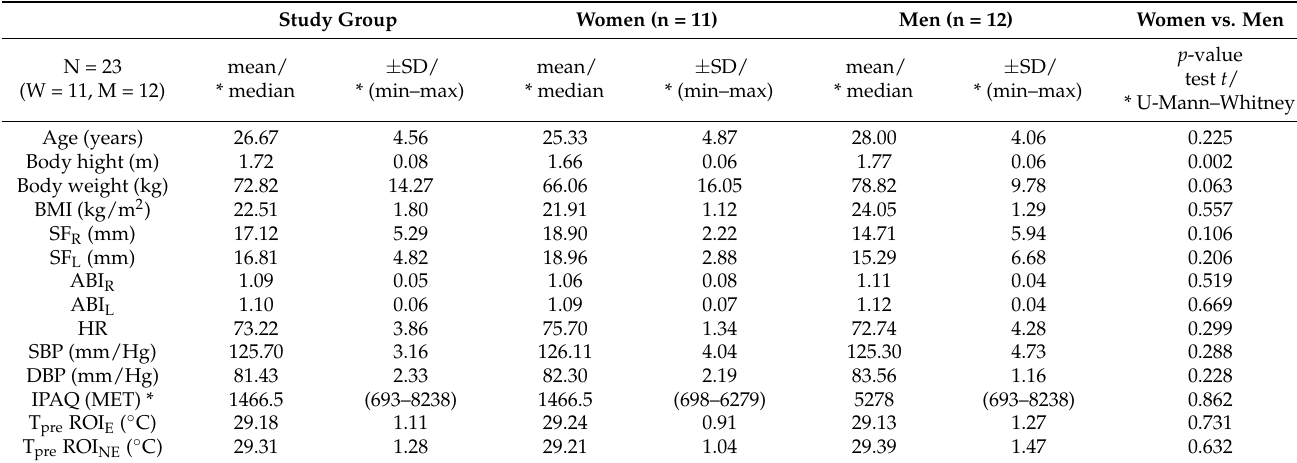
Figure 1. The course and sequence of research procedures. Table 1. Characteristics of the study group taking into account